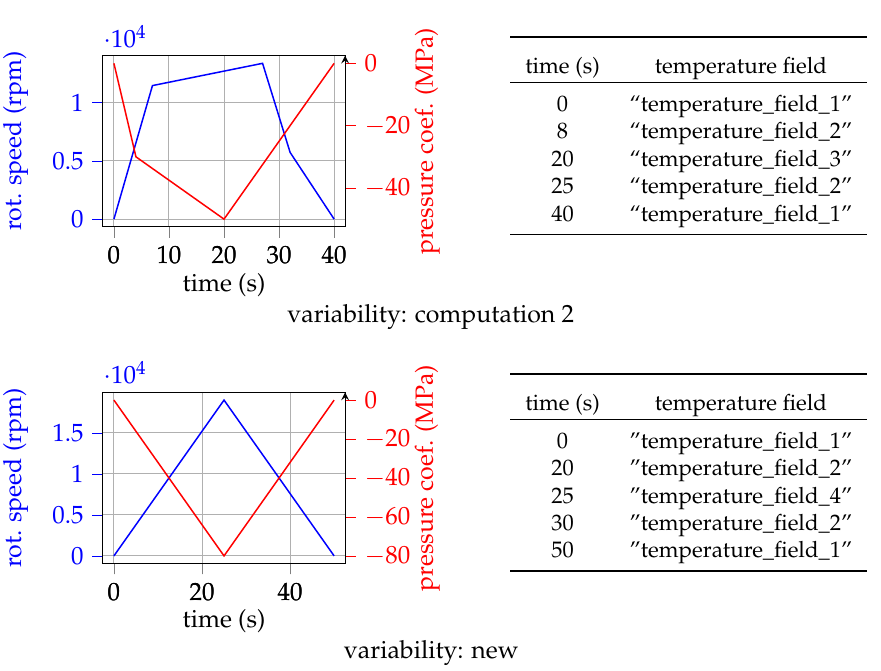
Figure 7. Considered loading variabilities for the academic test case. ( left ) Rotation speed ( ) and pressure coefficient ( ) with respect to time. ( right ) Temporal sequence for the temperature field.